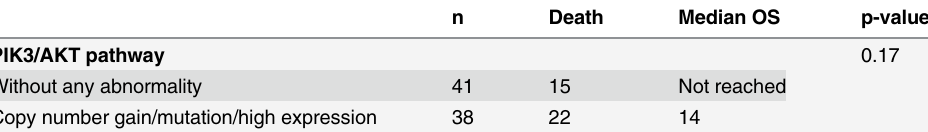
Table 6. Association between genomic events (CNV, mutation or gene expression) in any genes of PIK3/AKT pathway and